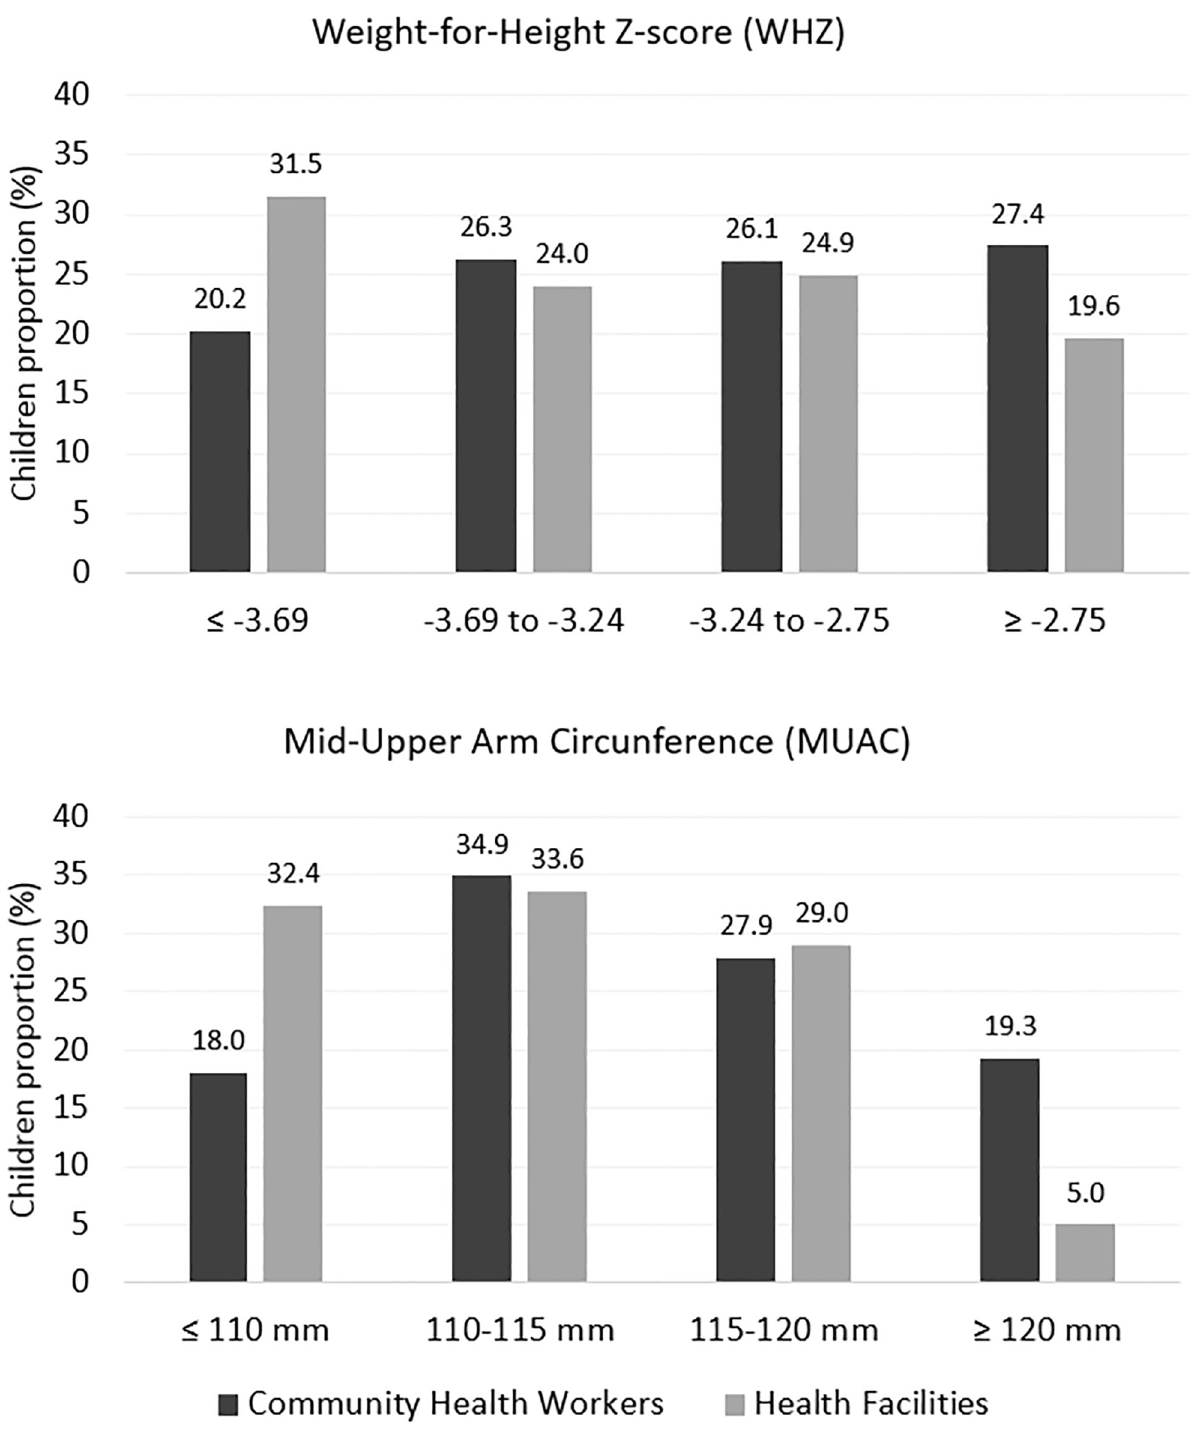
Fig 2. Distribution of children according to the quartiles of MUAC and WHZ at admission.